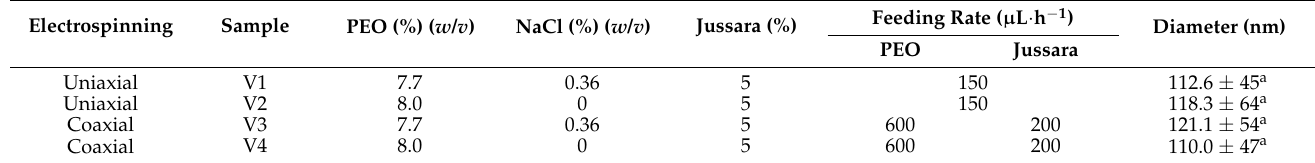
Table 2. Operation mode and process conditions for validation assays and the diameter measurements (nm) of core-shell NFs. Electrospinning